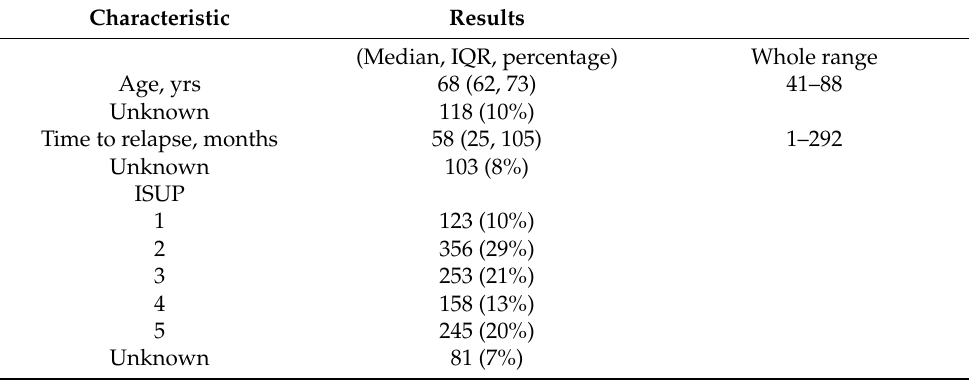
Table 1. Clinical